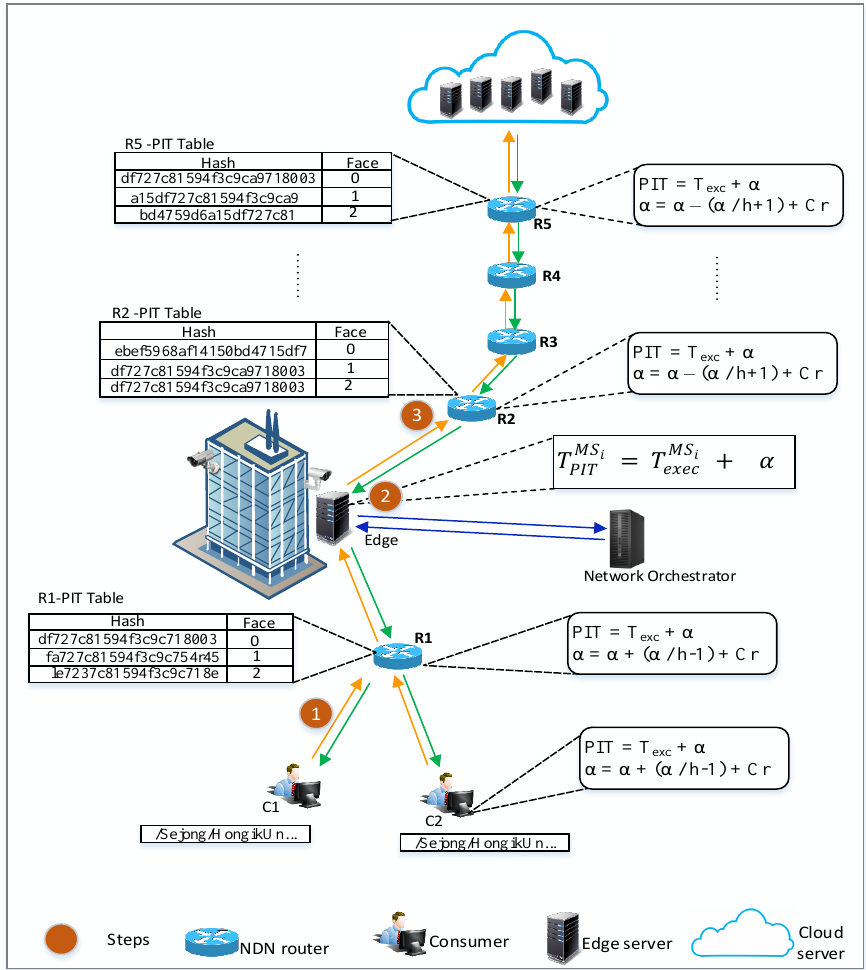
Figure 5. Dynamic PIT timer